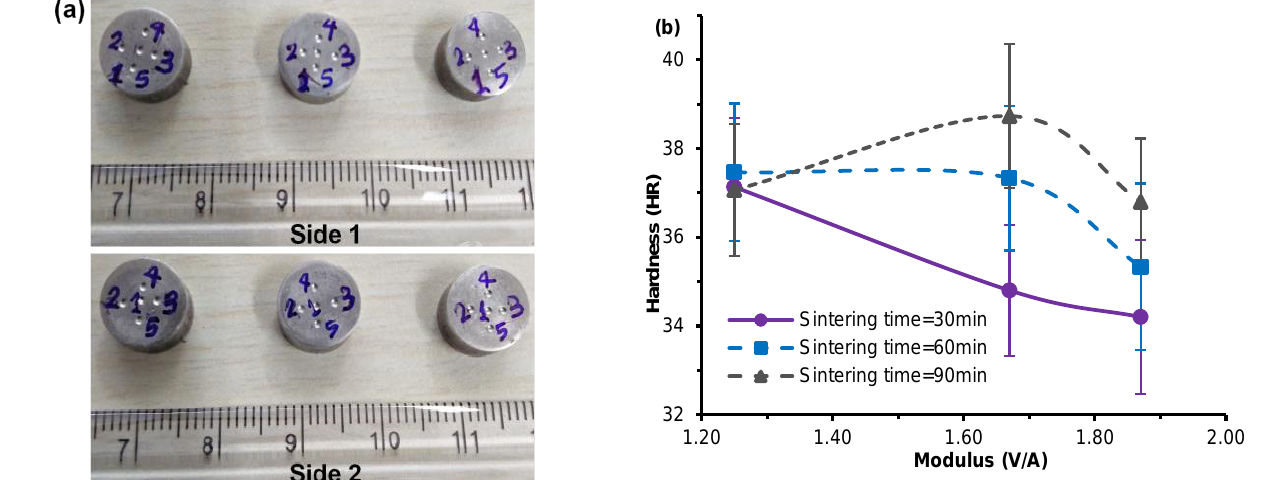
Figure 5. Hardness of the sintered aluminum MMCs (sintering temperature: 700 °C): ( a ) location of indentation on the test specimen and ( b ) variation in hardness with modulus.